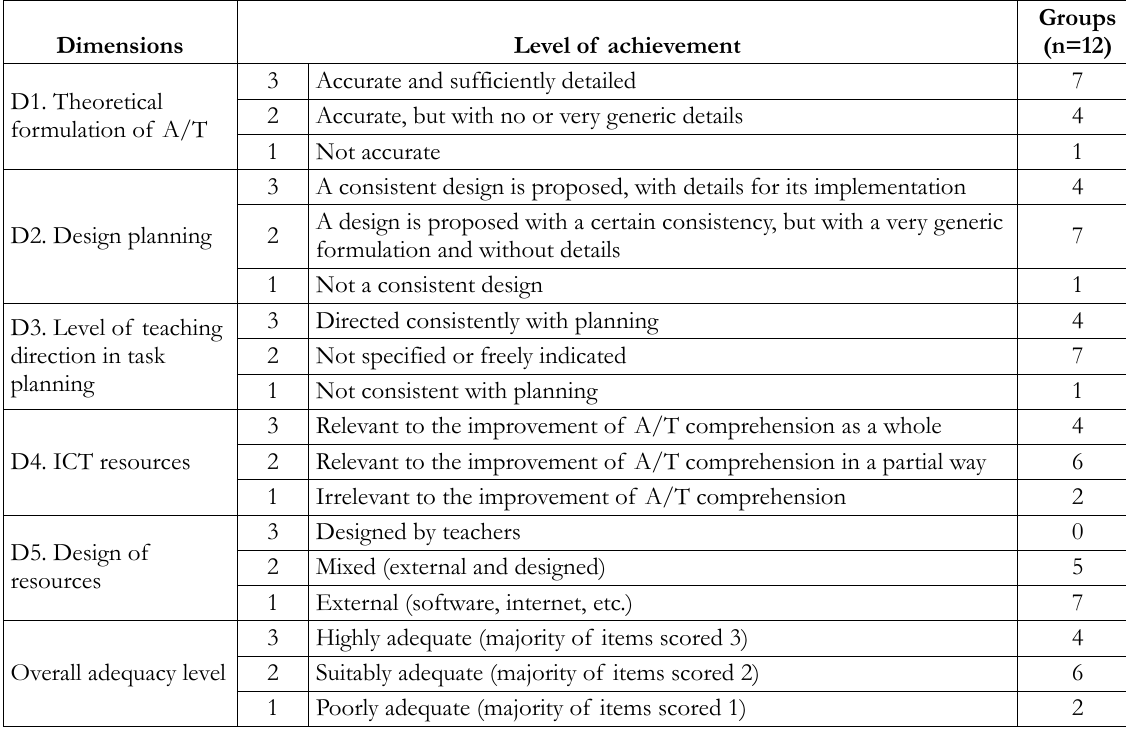
Table 11. Analysis of the designs made by